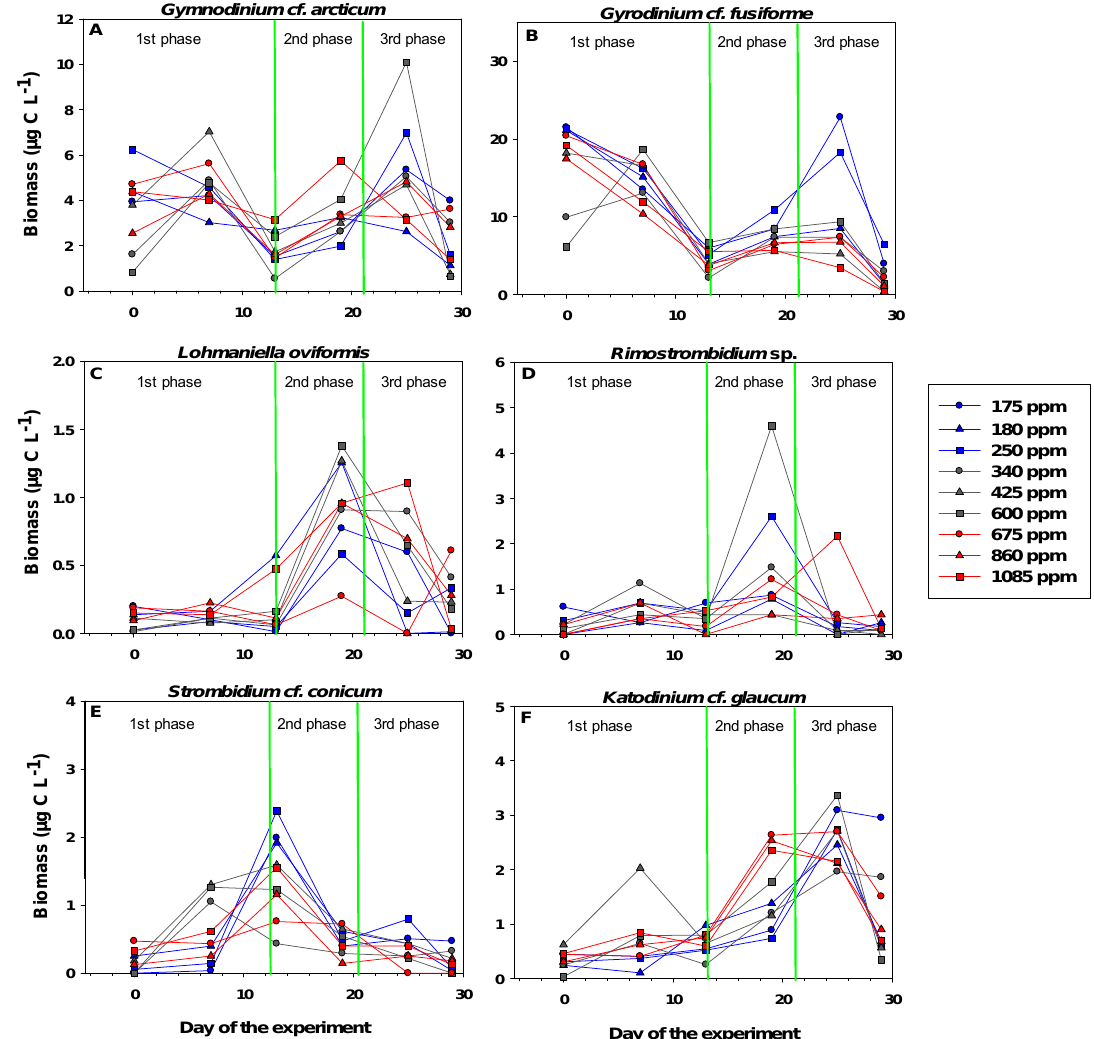
Fig. 4. Temporal succession of specific microzooplankton species: Gymnodinium cf. arcticum (A) , Gyrodinium cf. fusiforme (B) , Lohmaniella oviformis (C) , Rimostrombidium sp. (D) , Strombidium cf. conicum (E) and Katodinium cf. glaucum (F) in the different p CO 2 treatments (blue lines: p CO 2 of 175, 180 and 250; grey lines: p CO 2 of 340, 425 and 600; red lines: p CO 2 of 675, 860 and 1085). Note the different scaling on the y-axes. Vertical green lines depict the three phases of bloom development.